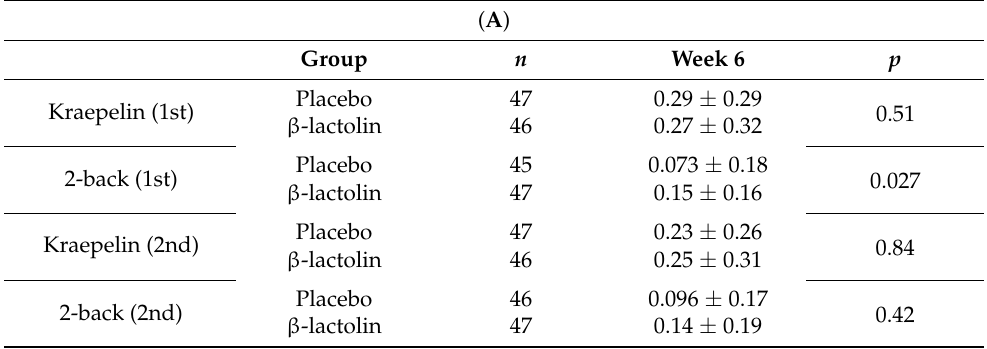
Figure 3. Representative total hemoglobin change during the working memory task. Total hemoglobin was monitored using a 2-channel NIRS. Representative change during the working memory tasks is shown in red (right channel) and blue (left channel) Table 2. Total hemoglobin measurement in the dorsolateral prefrontal cortex (DLPFC) using 2- channel near-infrared spectroscopy (CH NIRS). ( A , B ), changes in total hemoglobin (mM · mm) during the Kraepelin and 2-back tests in left and right channels measured using two-channel near-infrared spectroscopy, respectively.